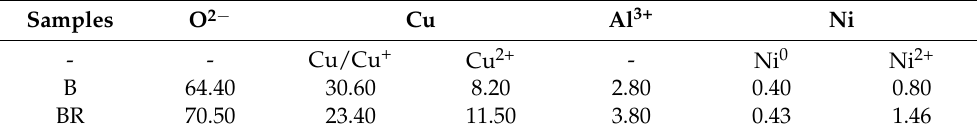
Table 4. Chemical elemental composition obtained from the XPS survey spectra in at.%. Samples